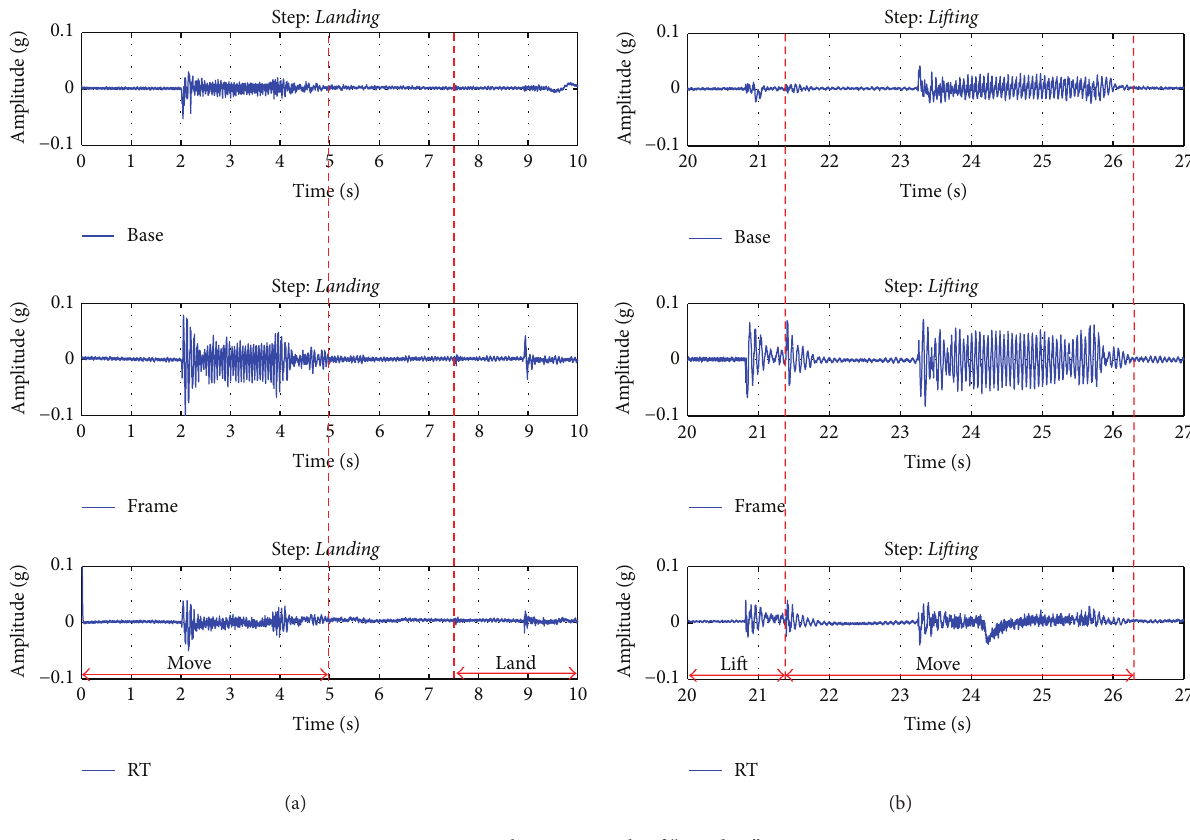
Figure 7: Vibration signals of “ Landing ”